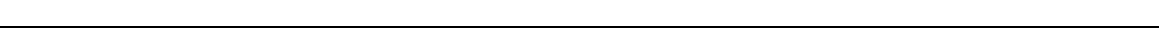
Fig. 4 Nicastrin is a membralin-dependent ERAD substrate. a Endogenous co-IP of nicastrin with membralin. Mouse brain organelle-enriched (nuclear and cytosol-free) lysates were precipitated with an anti-membralin antibody and immunoblotted with anti-nicastrin and membralin antibodies as indicated. A lower molecular weight band (~ 75 kDa) in the nicastrin blot was the brain organelle-enriched lysates treated with PNGase F to remove the glycosylation of nicastrin, serving as unglycosylated control. Untreated sample was used for endogenous co-IP, and shown in the input. b Western blot analysis and quanti fi cation of nicastrin protein levels detected in neuronal tissue from Mem + / + ( n = 4 mice) and Mem − / − ( n = 5 mice) animals. Data represent mean ± s.e.m. unpaired t -test, ** P < 0.01. c Western blot analysis of nicastrin protein levels measured in Mem + / + or Mem − / − mouse NPCs treated with 10 µ g/ml CHX for the indicated time. Data represent mean ± s.e.m. from three independent experiments, two-way ANOVA, ** P < 0.01. d Native PAGE western blot analysis and quanti fi cation of γ -secretase subunits (nicastrin, PEN2 and PS1-NTF) in brains from Mem + / + ( n = 4 mice) and Mem − / − ( n = 5 mice) animals normalized to β -actin levels from an equivalent quantity of denatured lysate. Data represent mean ± s.e.m. unpaired t -test, * P < 0.05. e Western blot analysis and quanti fi cation of NICD protein levels in Mem + / + and Mem − / − mouse NPCs. Data represent mean ± s.e.m. from 3 independent experiments, unpaired t -test, * P < 0.05. f γ -secretase activity was analyzed by measuring A β 40 and A β 42 generation in puri fi ed membrane fractions derived from Mem + / + ( n = 4 mice) and Mem − / − ( n = 5 mice) mouse brains. Data represent mean ± s.e.m. unpaired t -test, * P < 0.05, ** P < 0.01. g Golgi staining of the hippocampus of Mem + / + and Mem − / − mice (postnatal 3-day-old, n = 3 mice per genotype). Scale bars, 600 µ m (left), and 60 µ m in the magni fi ed images (right). Number of Golgi-staining + neurons per hippocampus ( n = 9 sections per genotype) and number of primary dendrites per cell were quanti fi ed ( n = 30-32 neurons per genotype). Data represent mean ± s.e.m. unpaired t -test, *** P <